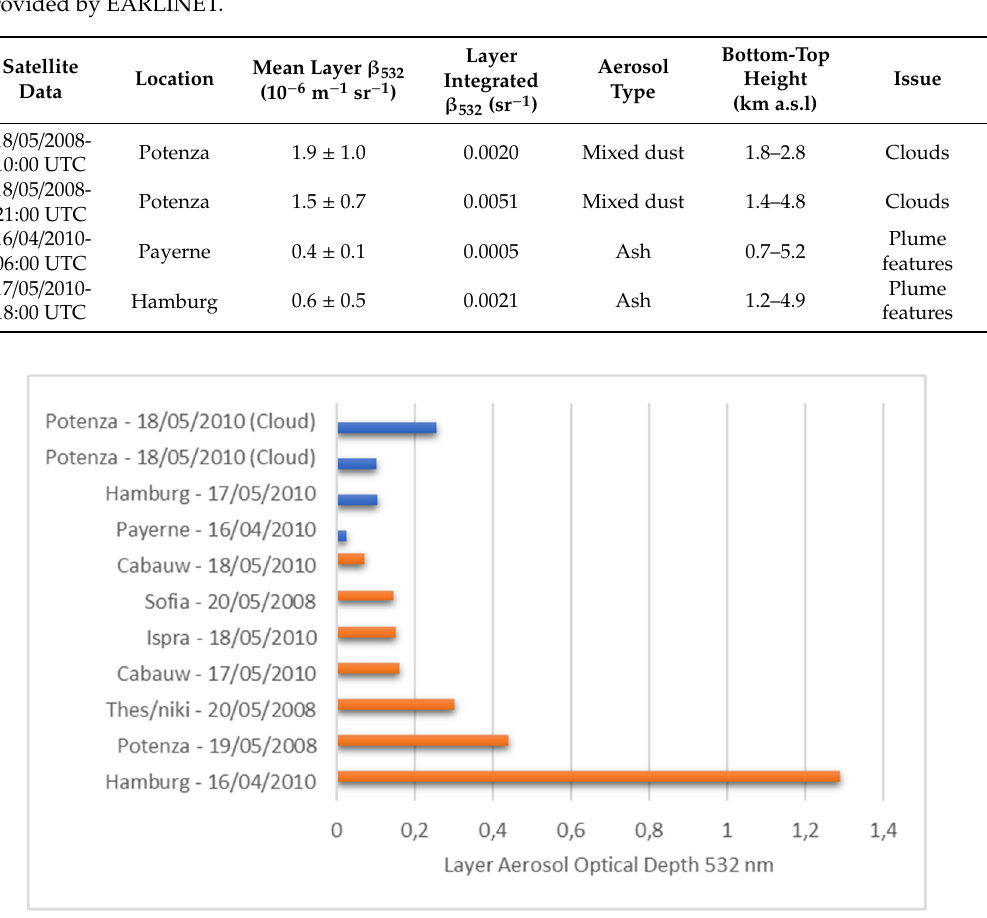
Figure 7 . Ash/dust layer aerosol optical depth (AOD) at 532 nm as estimated by EARLINET aerosol backscatter measurements (cases reported in Table 1 and 2). The backscatter coefficient to extinction coefficient conversion is made assuming a constant lidar ratio of 50 sr. The cases correctly detected by RST ASH and e RST DUST are reported in orange while the cases with no detection are reported in blue. A cloud label is reported for the cases in which ground-based stations identified clouds in the vertical column.